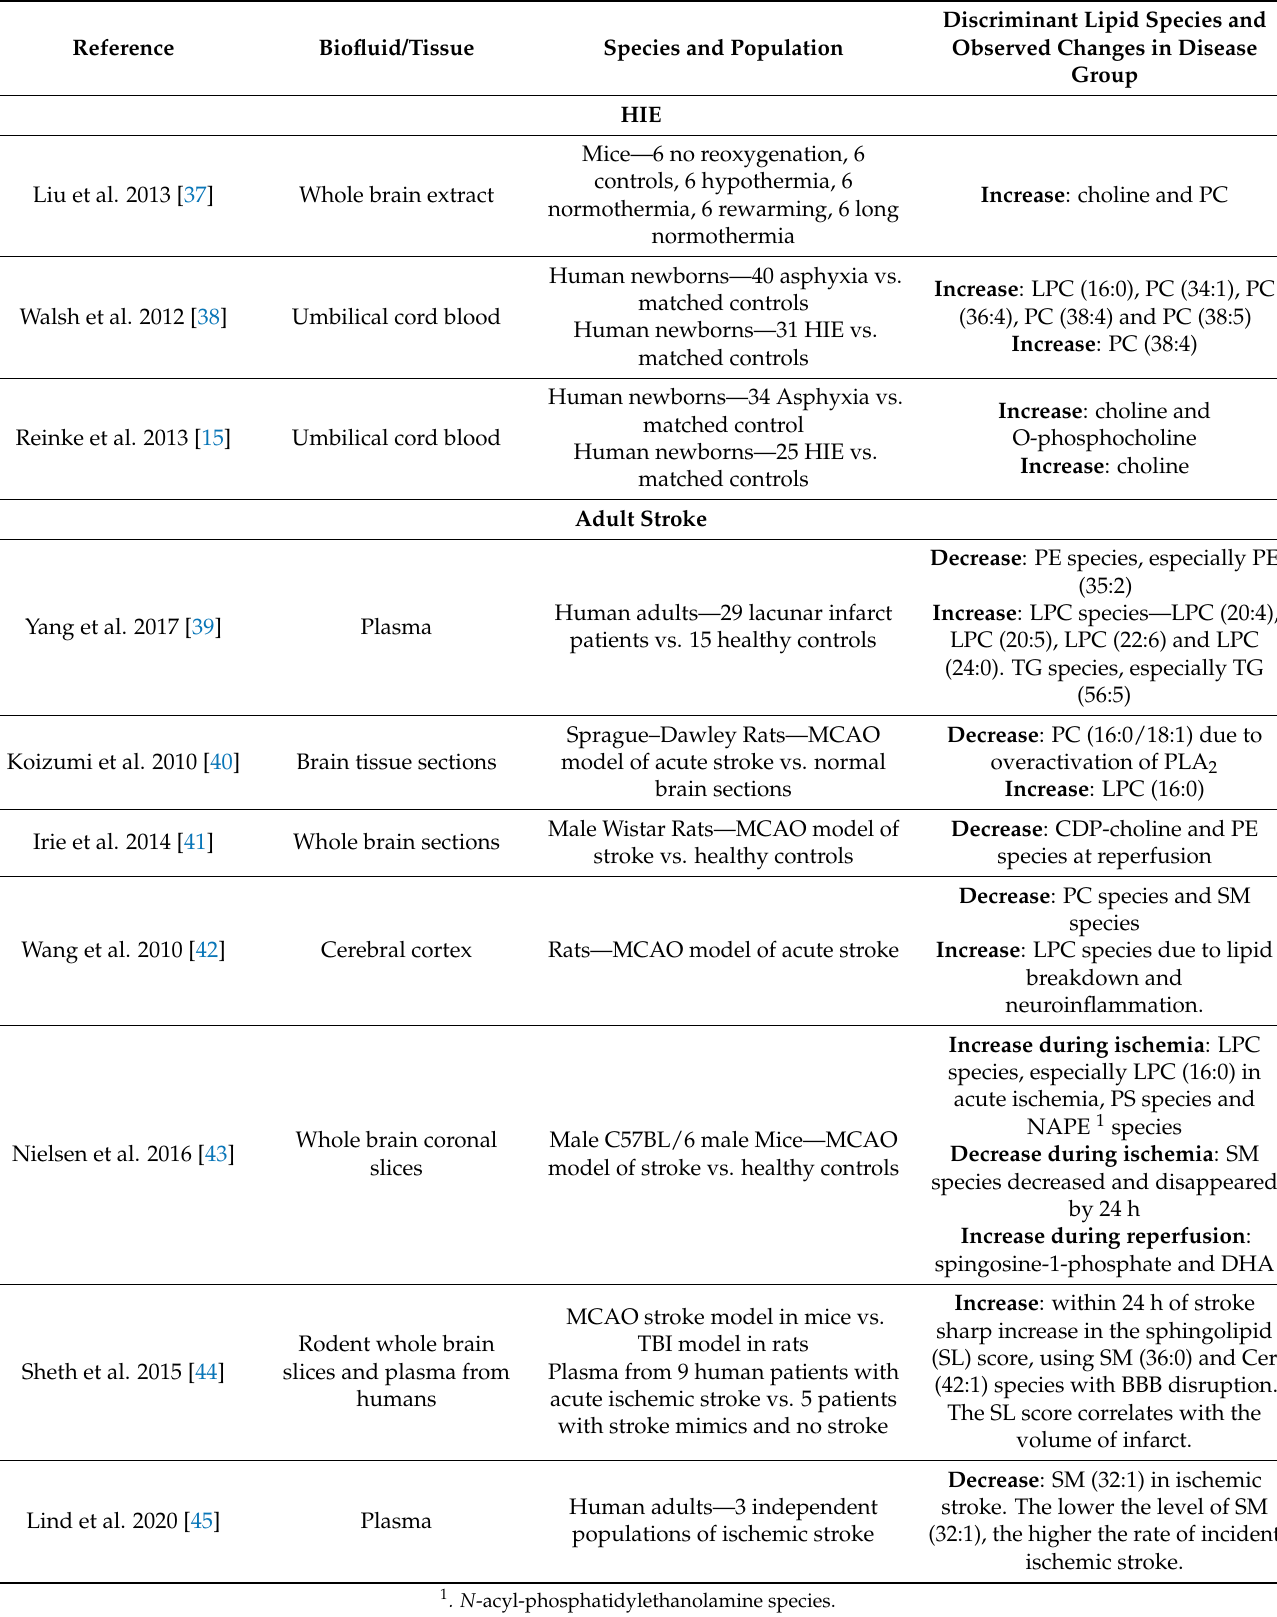
Table 7. Lipid analysis on animal models of and human studies of adult stroke and HIE Abbreviations: MCAO—middle cerebral artery